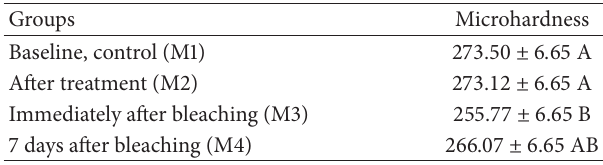
Table 1: Mean surface Knoop microhardness (KHN) values and standard error for the factor time intervals.